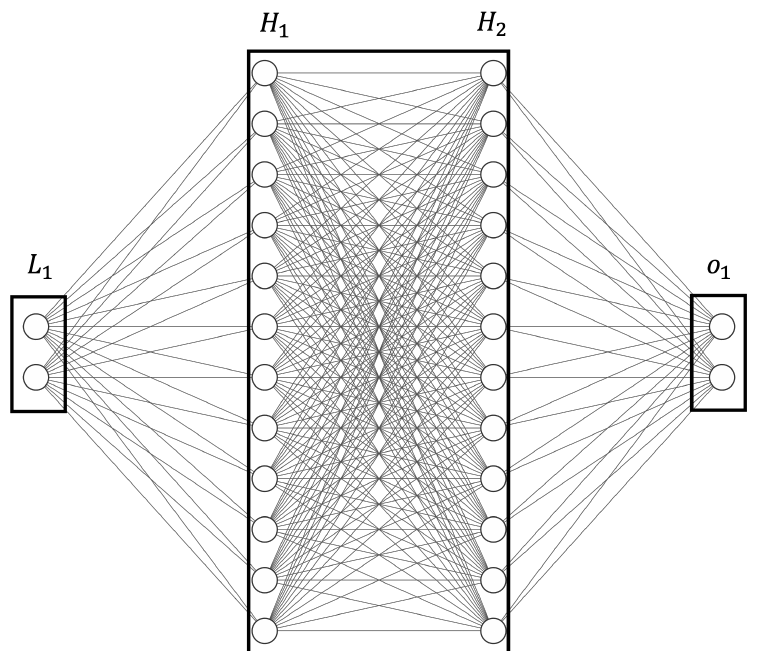
Figure 6. Conceptual diagram of a feed-forward, fully connected DDNN. DDNNs have been applied in multiple cyber-security tasks [12,26,43,44,48,49,67] because of their ability to effectively analyze different backgrounds, types of values, and measurements in the collected data, often from sources that are presented in real time. The propagation of desired feature information between multiple neurons in the hidden layers H 1 and H 2 is strengthened, maximizing the recognition capability of a sample, in this case, cryptojacking.